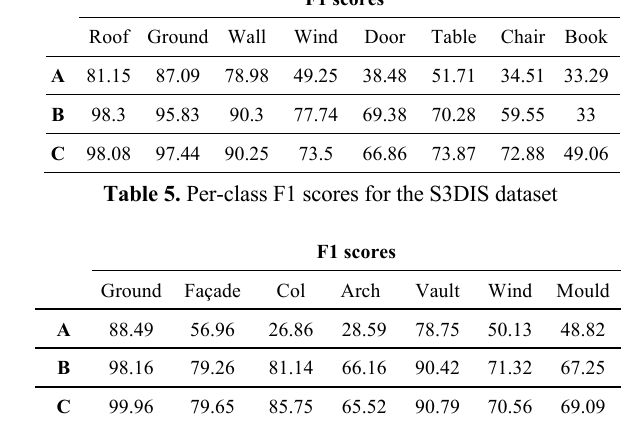
Table Chair Book